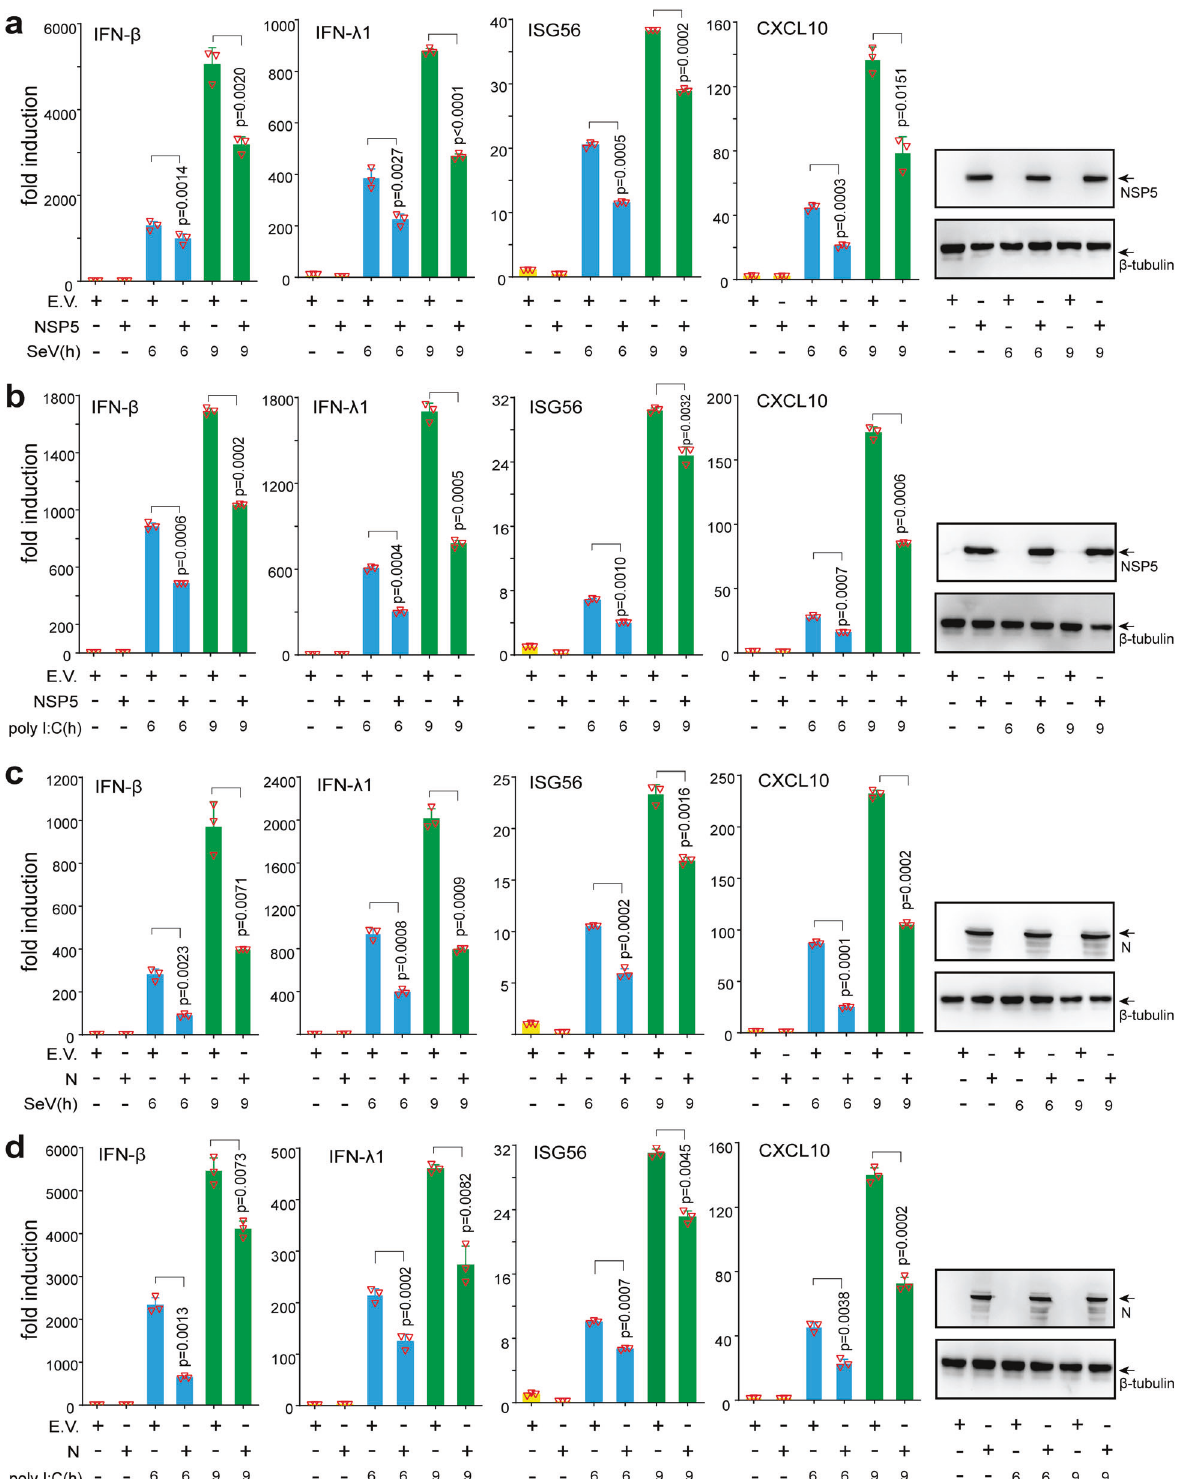
Fig. 3 NSP5 and N proteins inhibit IFN production. A549 cells were transfected with plasmids of empty vector, NSP5 ( a and b ), or N protein ( c and d ) as indicated, 24 h later. the cells were further stimulated with SeV ( a and c ) or poly (I:C) ( b and d ). At the indicated time points, cells were collected for RT-qPCR analysis to determine the relative expression levels of target genes normalized by GAPDH. Data are presented as mean values ± SEM from three biological replicates from one representative experiment of two. EV empty vector, h hours.